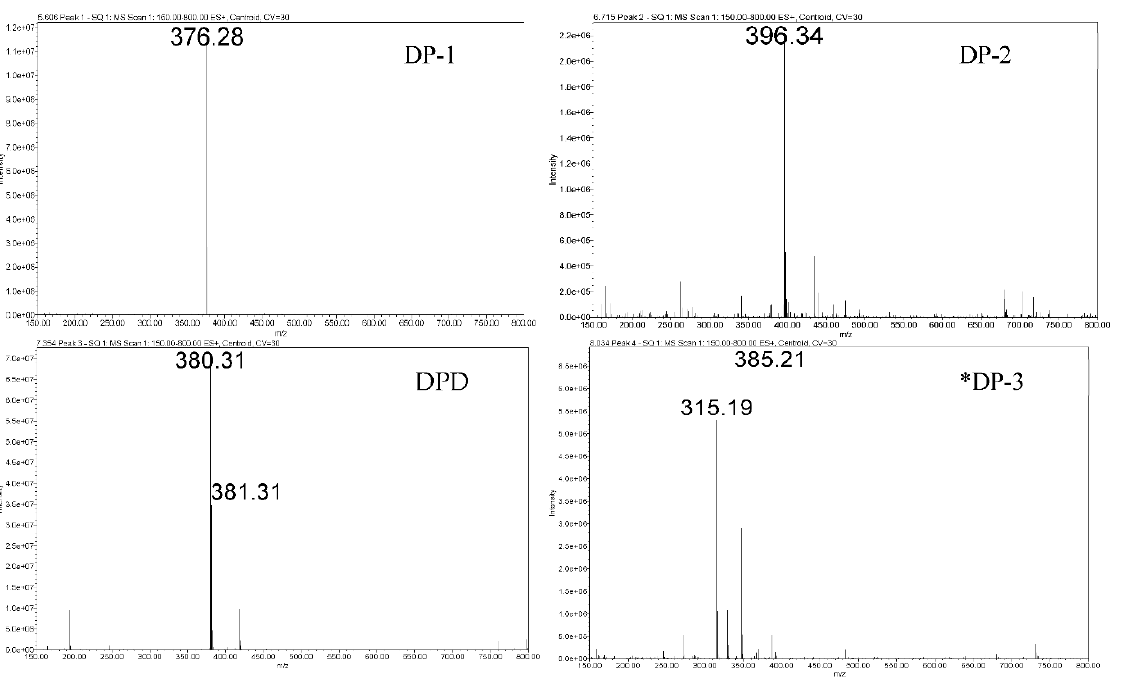
Figure 3. Chromatogram showing the formation of DPs in DPD:AIBN compacts when exposed to different oxidative conditions and an enrichment of DPs when exposed under high oxygen pressures (400 kPa) in RapidOxy ® .